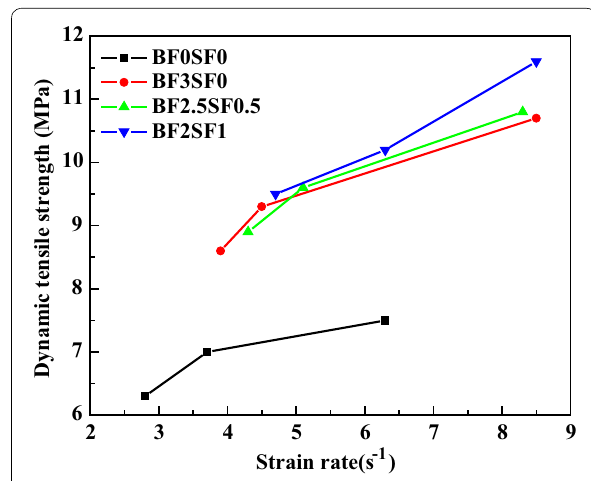
Fig. 10 Dynamic tensile strengths of various specimens at different strain rates.